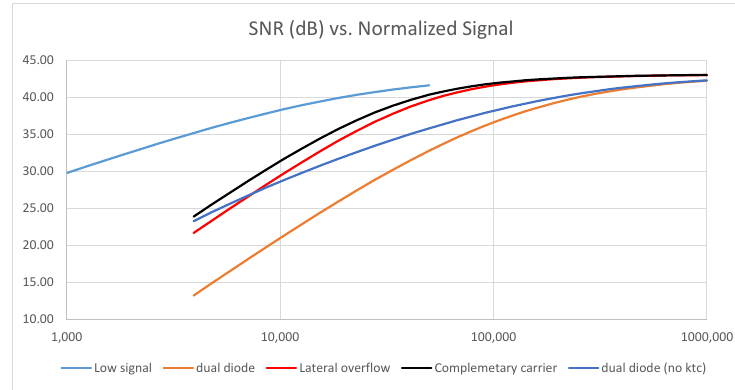
Figure 5. Architecture benchmark for a 1 Me− equivalent full well pixel, simplified model. SNR: signal-to-noise ratio.